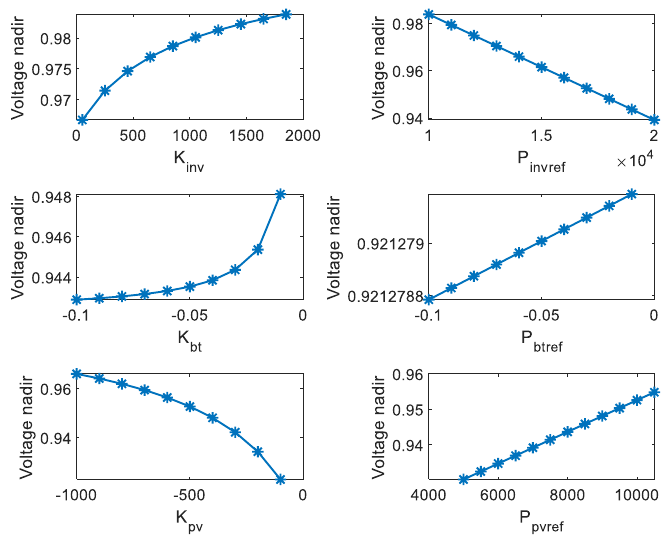
Figure 22. Sensitivity analysis of voltage nadir (p.u.).